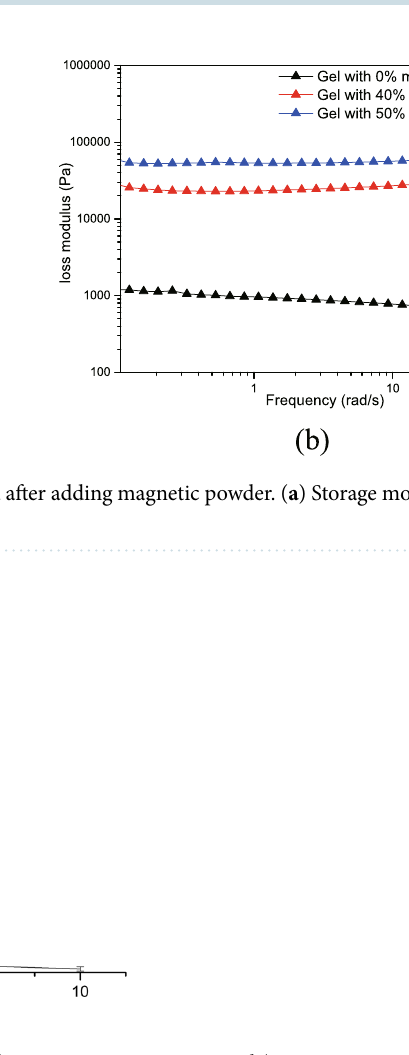
Figure 4. Change in magnetic force with distance between 0.2 mL magnetic gel (50% magnetic particle content, 3% sodium alginate) and the pursuit magnet (10 mm in diameter, 3 mm in